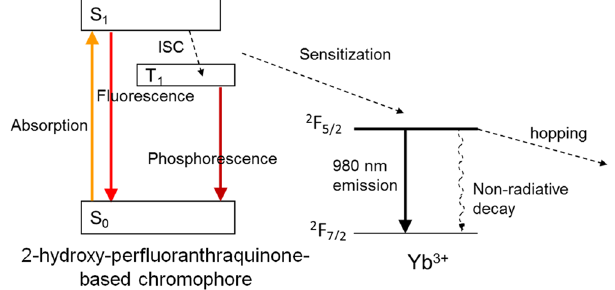
Figure 3. Simplified schematic representation of organic-chromophore mediated Yb 3 + sensitization process (Jablonski diagram): S 0 : ground state of chromophore, S 1 : excited singlet state, T 1 : excited triplet state, ISC: inter- system crossing. Energy (vertical) scale is not